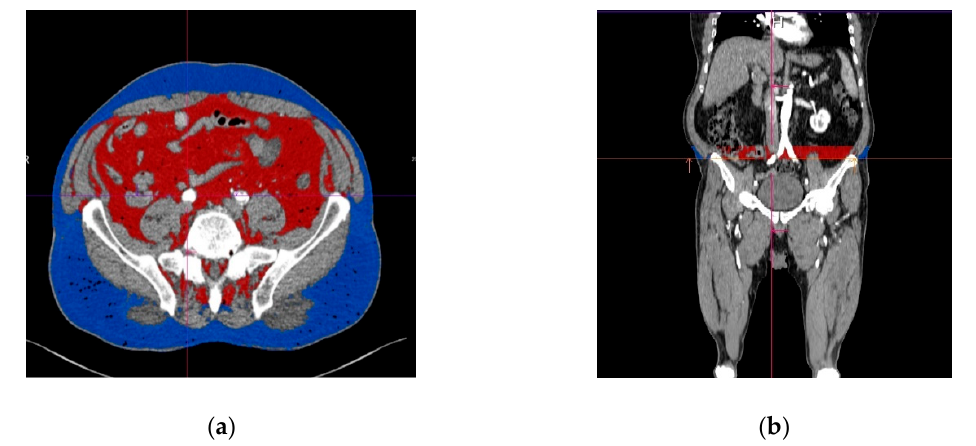
Figure 3. Subcutaneous and visceral adipose tissue determined with angio CT (computed tomography angiography), measured at the level of the origin of the right common iliac artery. ( a ) Transverse view, ( b ) longitudinal view. The visceral adipose tissue is represented in red, while the subcutaneous adipose tissue is represented in blue.